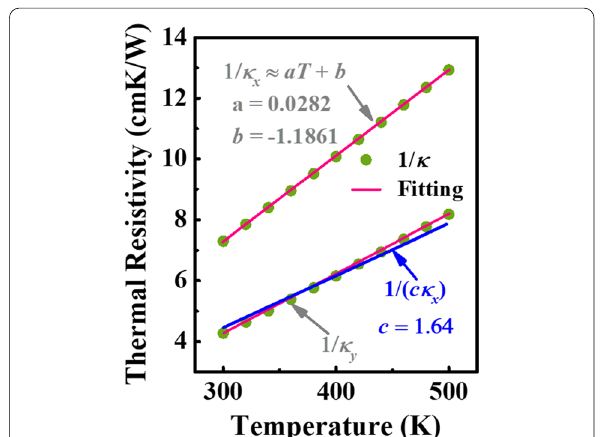
Fig. 2 The relationship between the thermal resistivity and T for directions of [001] and [010]. Green symbols and red lines denote actual and fitted values, respectively. Blue line represents the hypothesis of 1/ κ y 1/( cκ x ), where c ≈ =